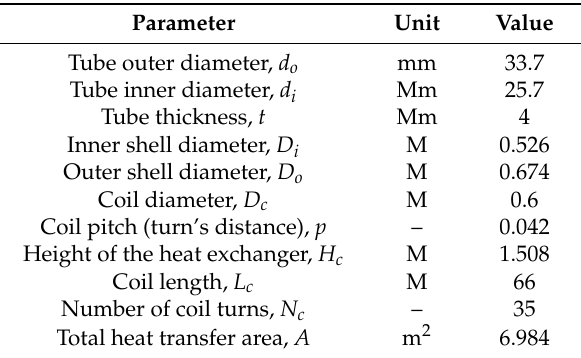
Table 2. Summary of the final geometrical values of the helical coil heat exchanger.